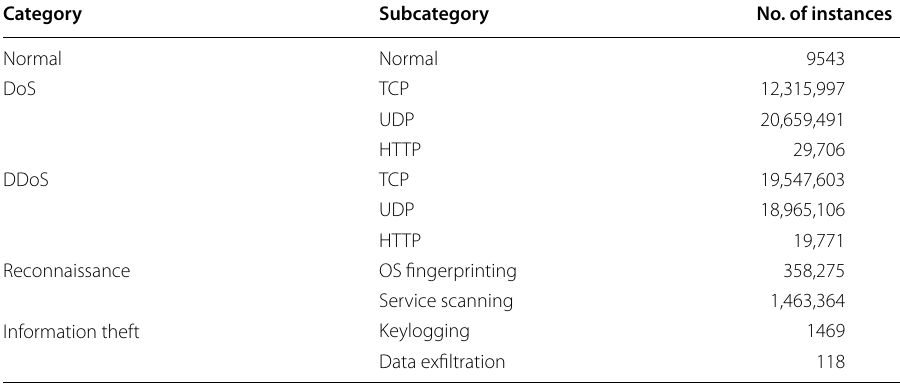
Table 1 Bot-IoT: full set